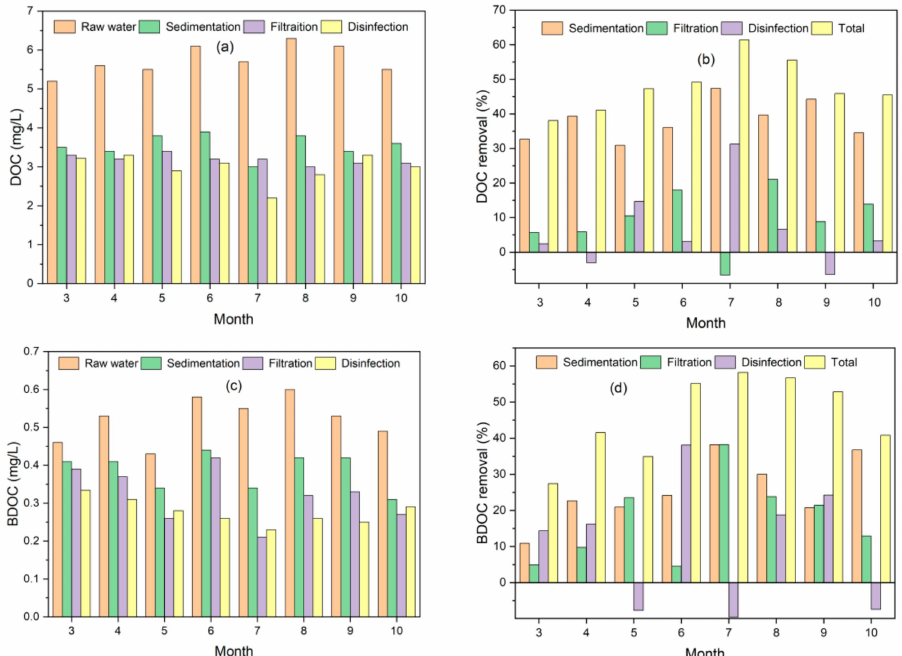
Figure 2. DOC and BDOC removal in the water treatment plant in different months. ( a ) DOC concentrations; ( b ) DOC removals; ( c ) BDOC concentrations; ( d ) BDOC